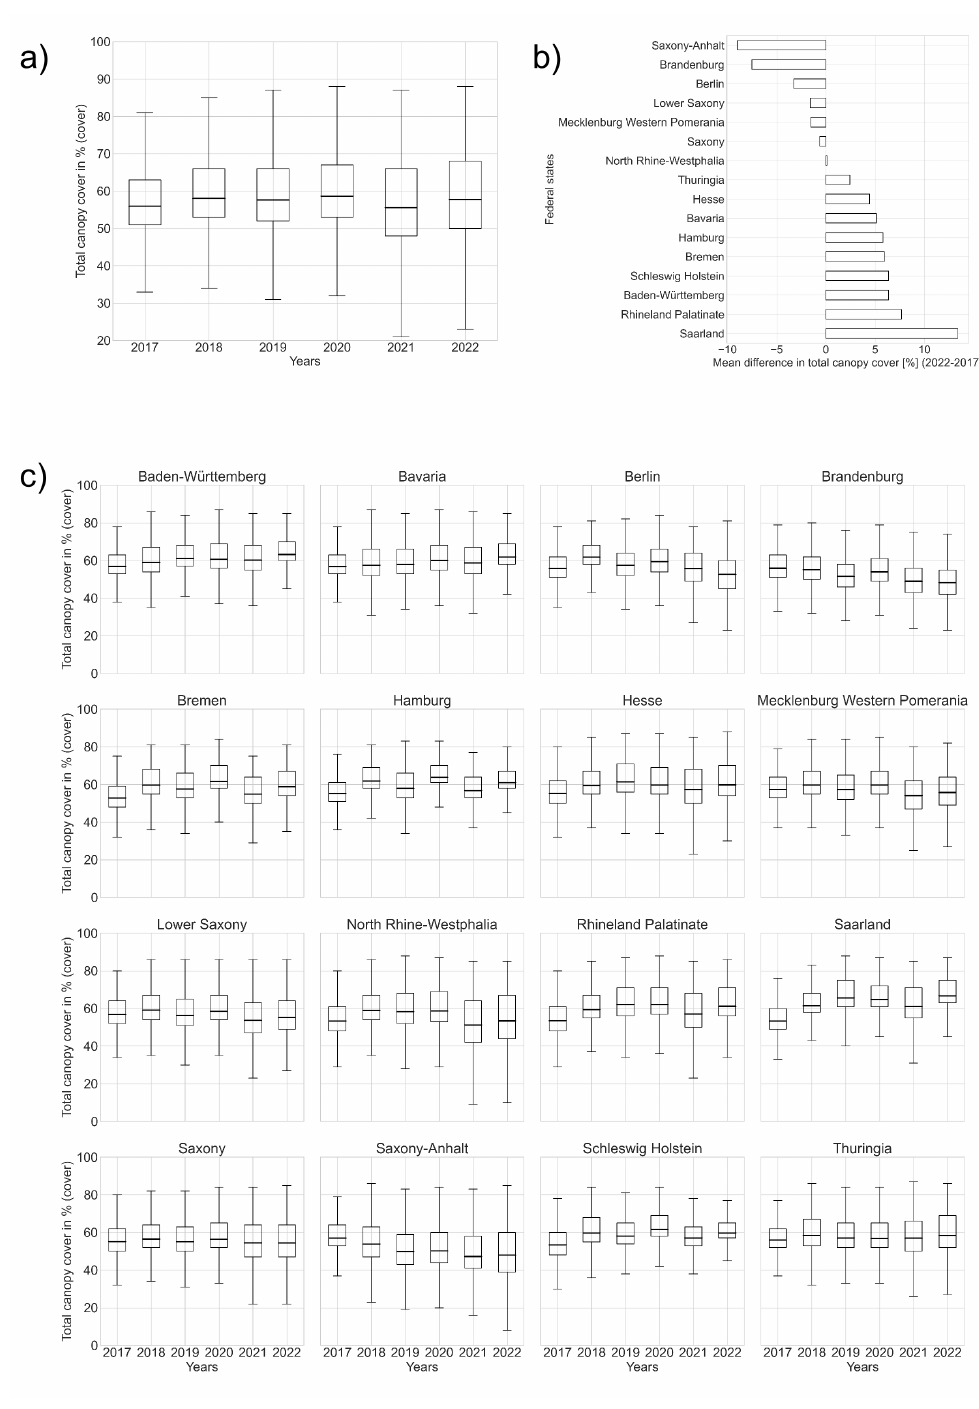
Figure A1. Quantitative statistics of total canopy cover in forested areas of Germany: Overall dynamics in total canopy cover in Germany ( a ), mean difference in total canopy cover (2022-2017) among federal states ( b ), multi-temporal change in total canopy cover grouped by federal states ( c ). The statistics are based on predicted pixel estimates depicting mean values as horizontal line in the boxplots. General dynamics of forest structure are assessed; absolute values should be interpreted in the context of model